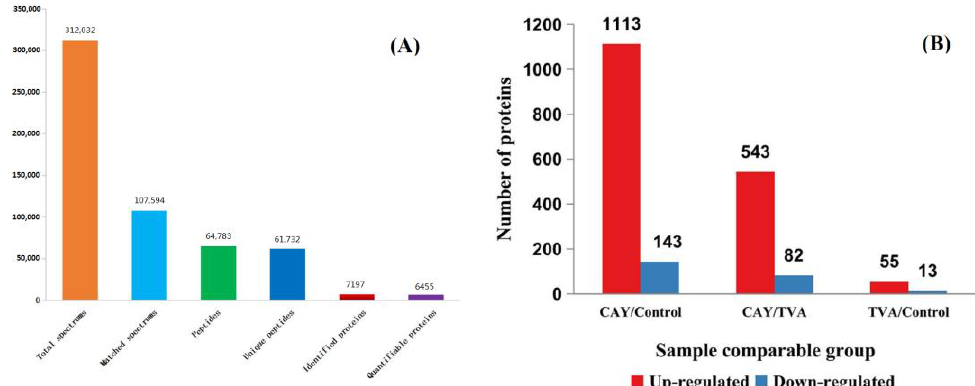
Figure 2. Statistics of mass spectrum data ( A ) and the number of differentially expressed proteins difference protein between groups of MAC-T cells under different incubation conditions ( B ). CAY group (SCD1-inhibited MAC-T cells model): incubated with 50 µ M TVA for 2.5 h after CAY10566 treatment at concentrations of 10 nM for 12 h, TVA group: only incubated with 50 µ M TVA for 2.5 h, and control group: without CAY, TVA. Differential proteins were screened from quantifiable proteins with p -value < 0.05, and a differential expression change more than 1.3/1 was defined as the threshold of change for significant up-regulation, while a change of less than 1/1.3 was the threshold of change for significant down-regulation.